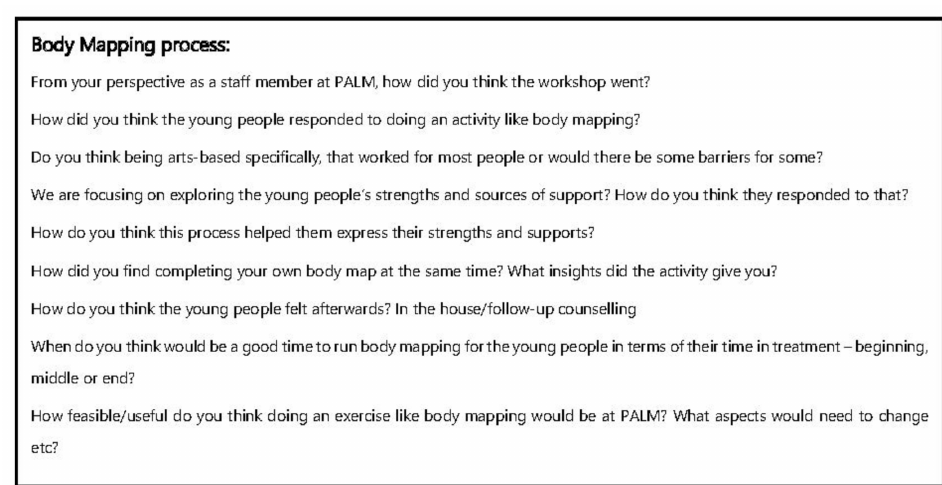
Figure 1. Interview Guide for Body Mapping Participants.